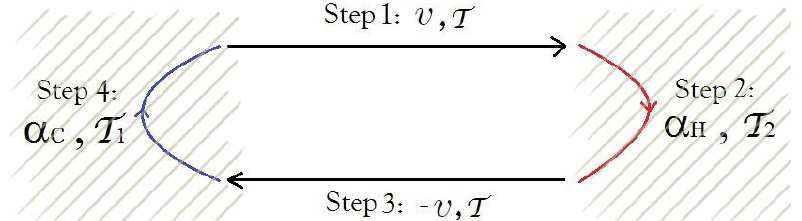
Figure 2. The relativistic kinematic cycle of the qubit. In dashed gray lines are shown the regions of contact between the qubit and the quantum vacuum